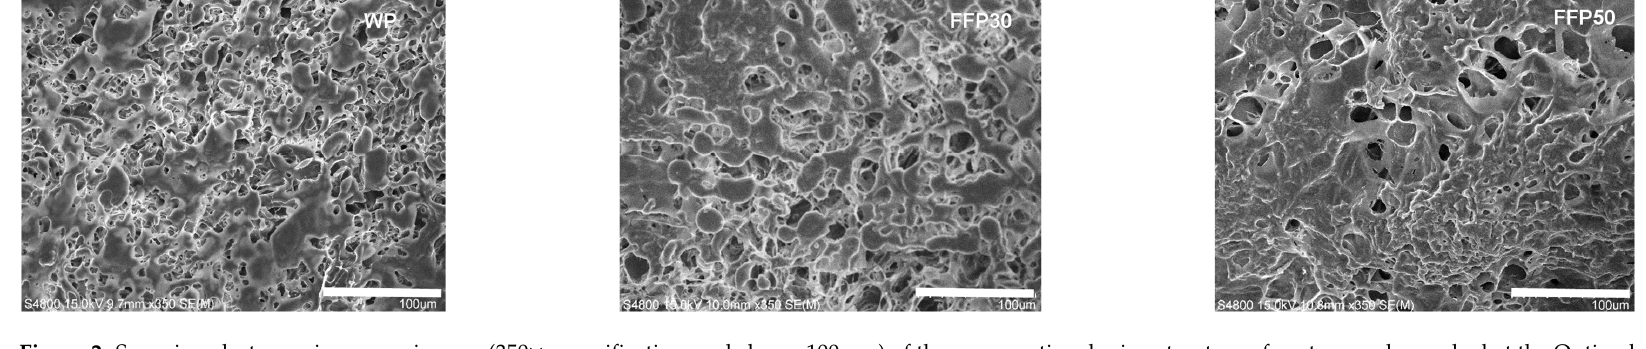
Figure 2. Scanning electron microscopy images (350× magnification, scale bar = 100 μ m) of the cross-sectional microstructure of pasta samples cooked at the Optimal Cooking Time (OCT). WP, pasta made with wheat semolina; FFP30 and FFP50, faba bean pasta including 30 or 50% ( w/w ) fermented faba bean flour in replacement of semolina [51].